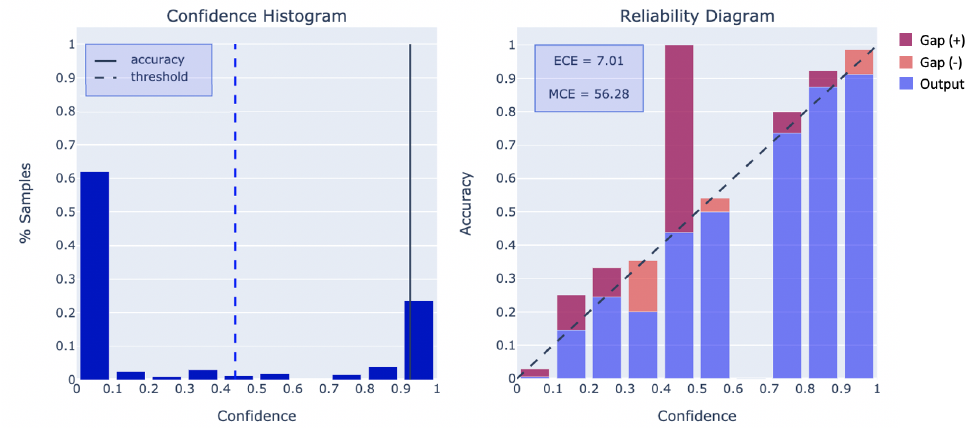
Figure 6. Resnet50 + FPN calibration assessment: confidence histogram (left) and reliability diagram (right). The former shows the distribution of confidence scores over the dataset the latter compares the model behavior to the ideal case of a perfectly calibrated classifier represented by the dashed